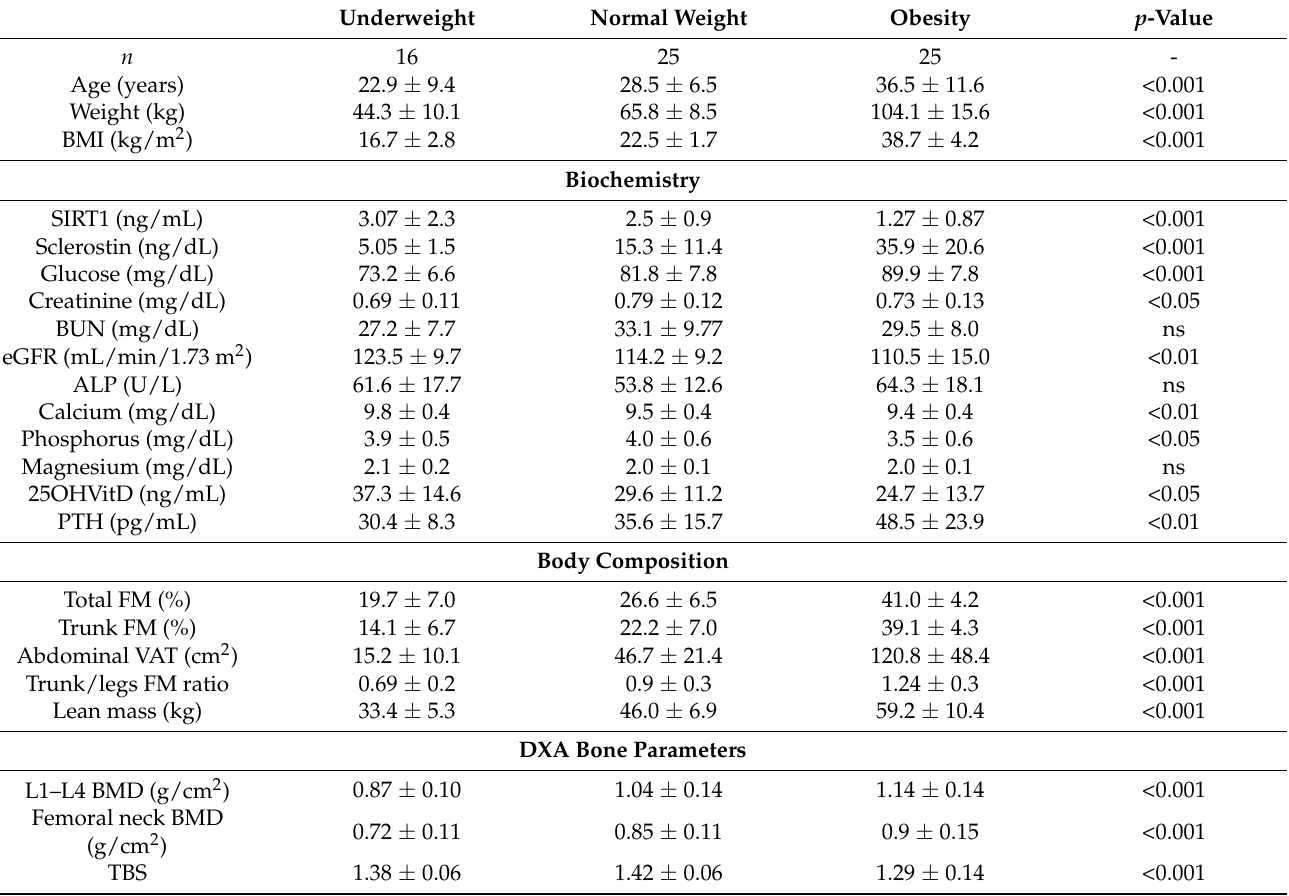
Table 1. Demographic, anthropometric and clinical characteristics of the study patient population.